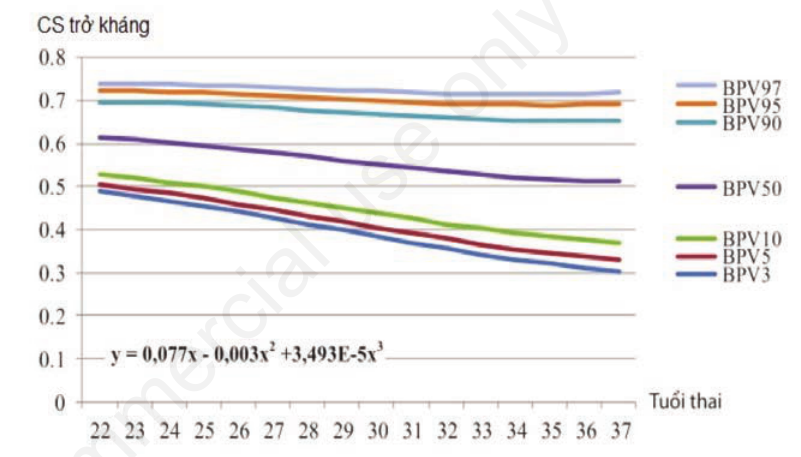
Figure 4. DVRI centile diagram for gestational age 22-37 weeks.